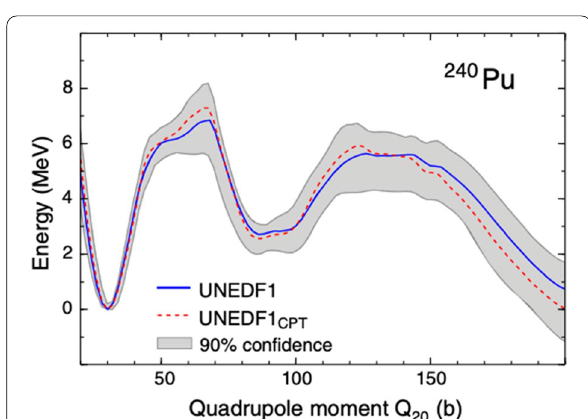
Fig. 6 Potential energy profile for 240 Pu calculated with UNEDF1 (solid line) and UNEDF1 CPT (dashed line, suffix CPT indicates that the parameters are optimized on a data set that also includes masses measured at the Canadian Penning Trap) EDF. Gray area is the 90% confidence interval of the potential profile. The figure is adapted from